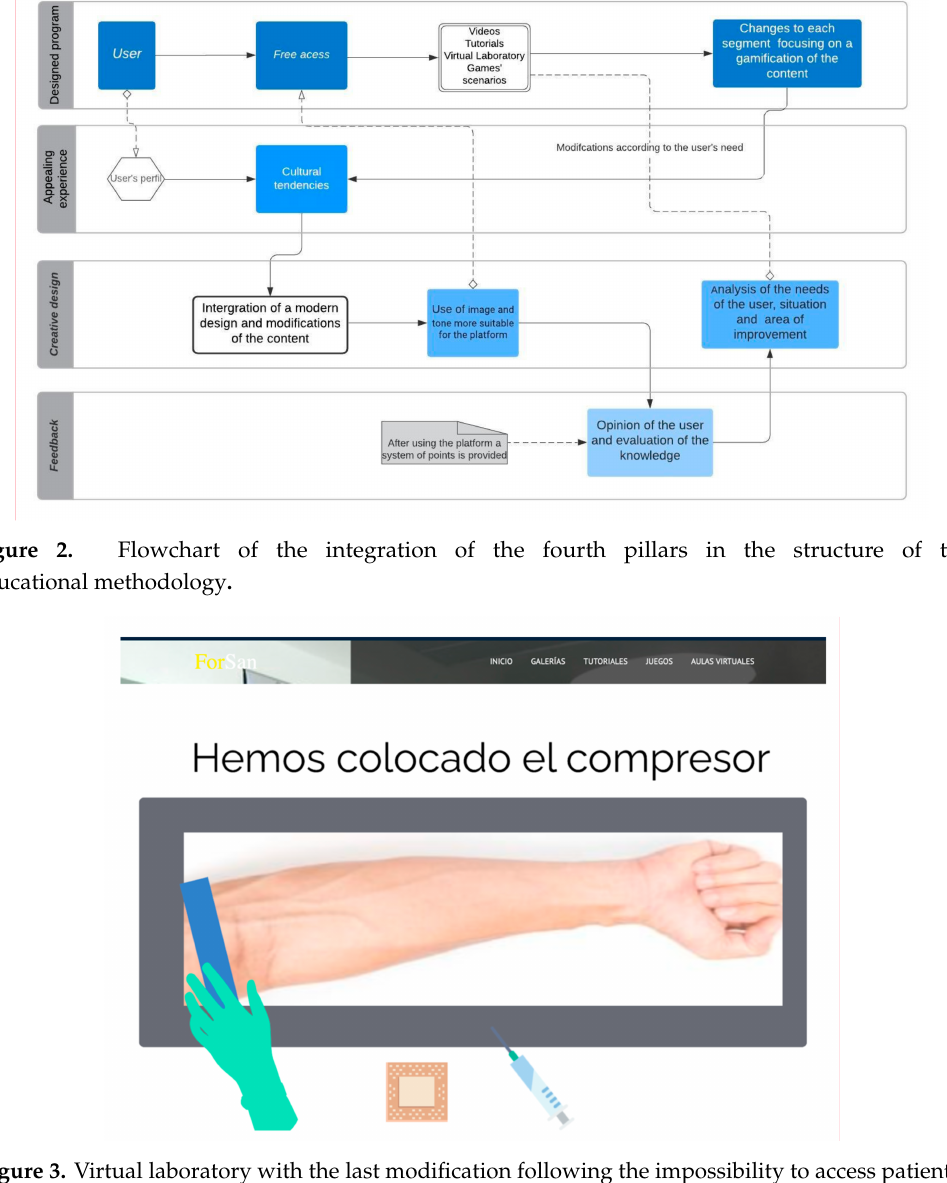
Figure 3. Virtual laboratory with the last modification following the impossibility to access patients